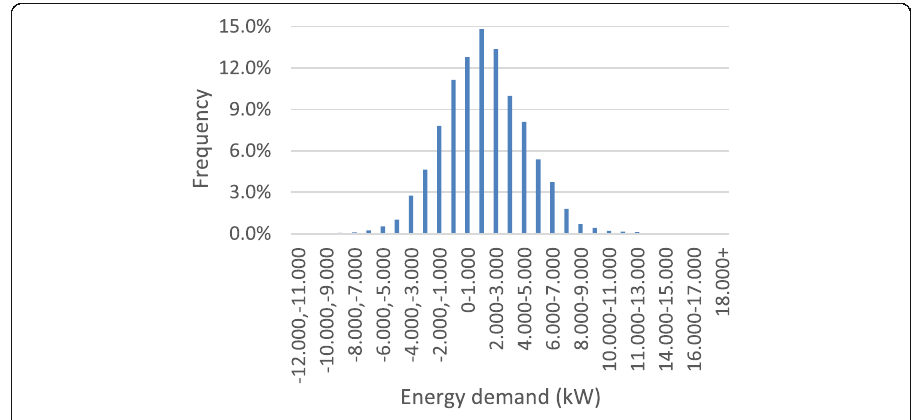
Fig. 7 Frequency (per 0.1 s) per energy demand